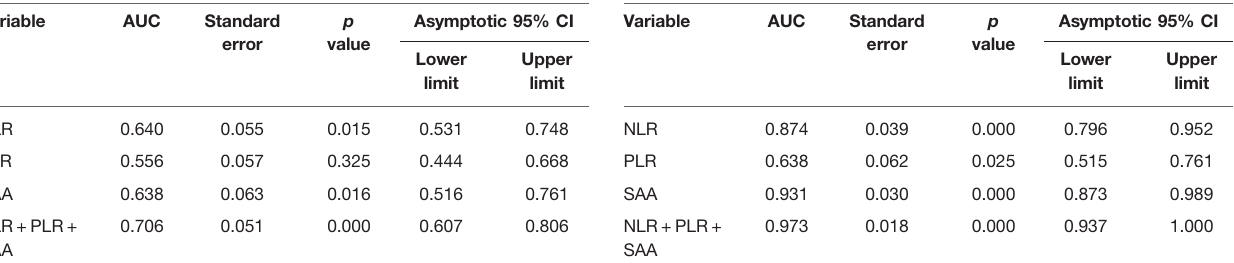
TABLE 4 | Value of serum NLR, PLR and SAA levels in predicting patients with stage IV